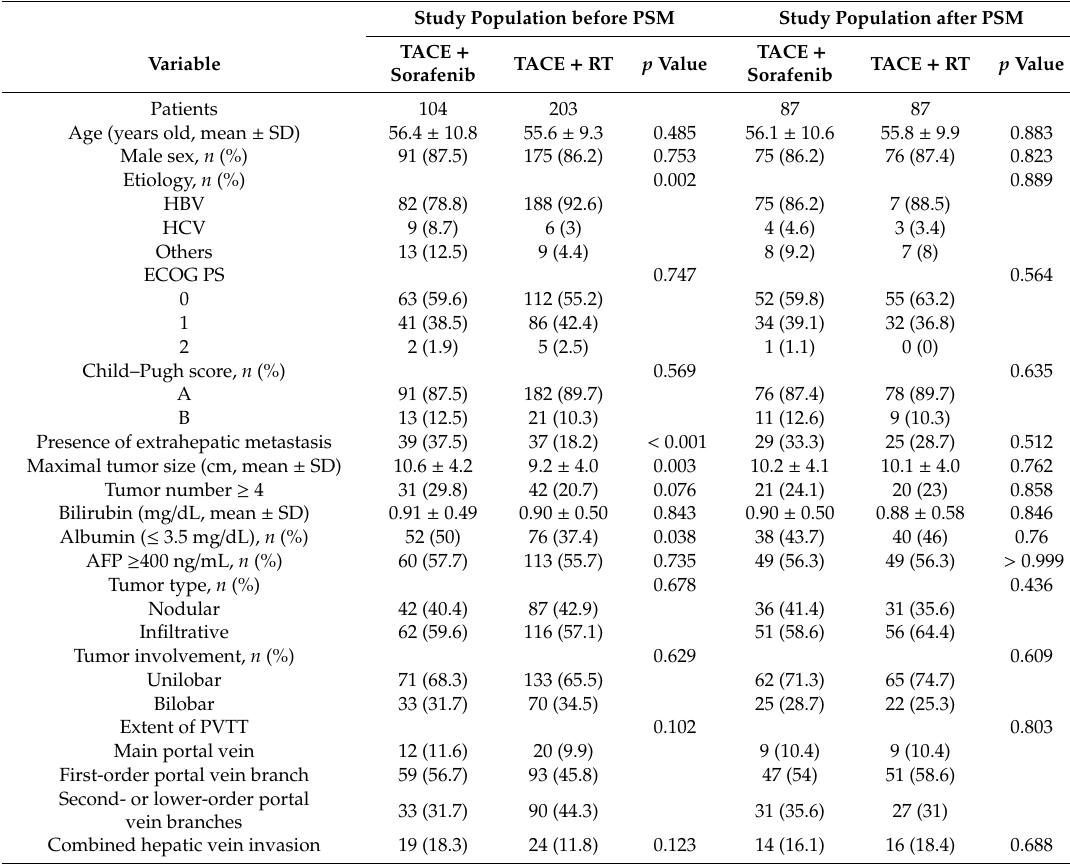
Table 1. Baseline patient